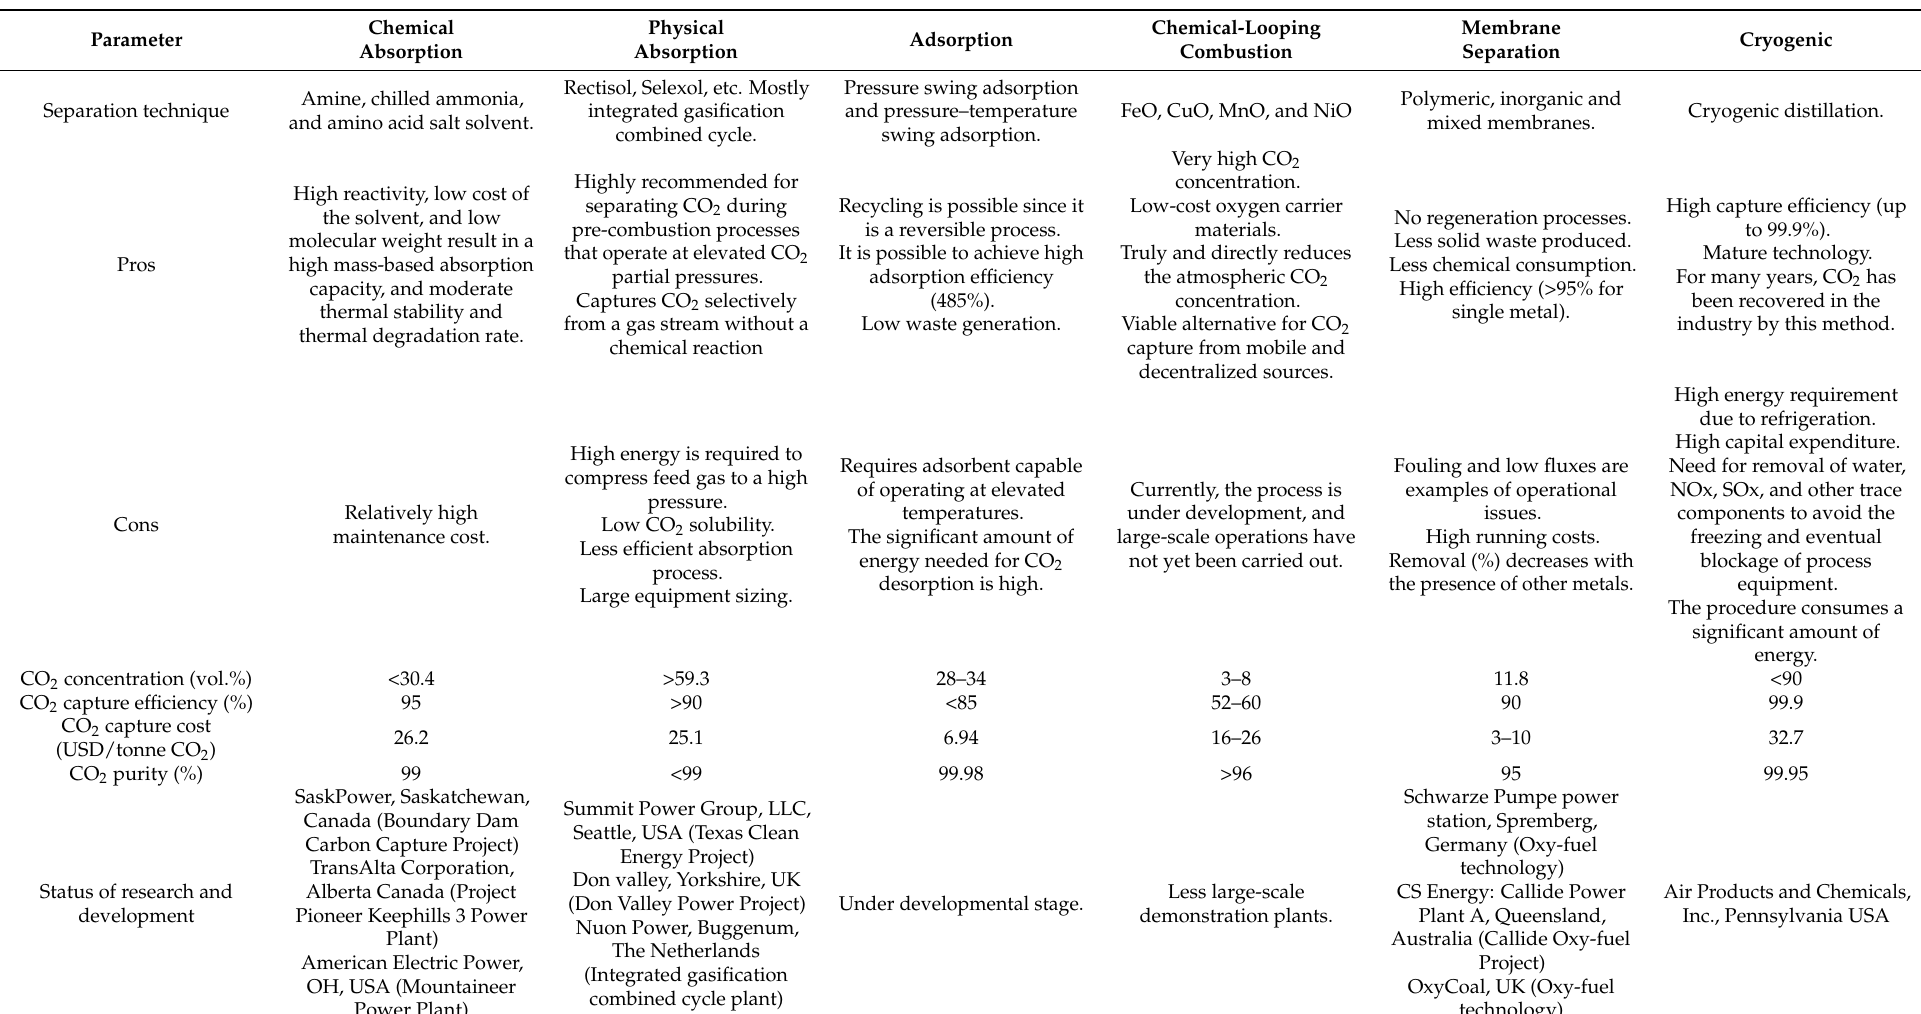
Table 7. Current status of different separation technologies for CO 2 capture